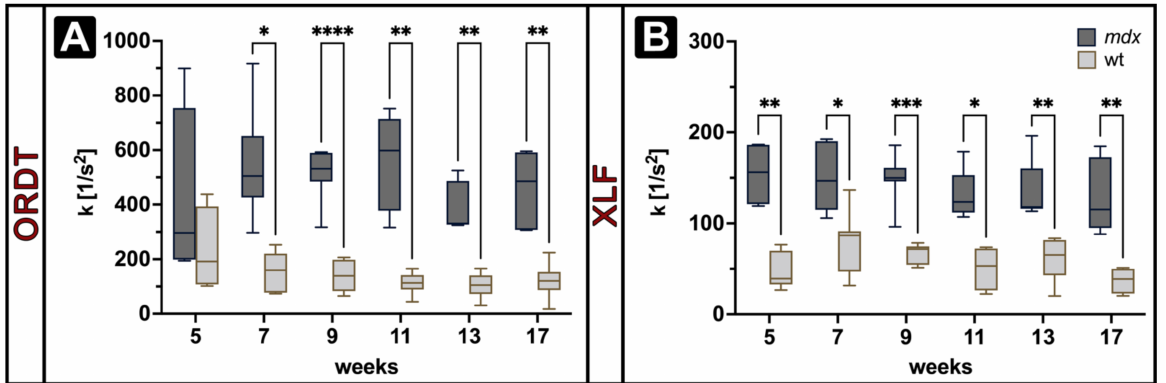
Figure 3. Expiration constant ( k ) derived from ORDT ( A ) and XLF ( B ) measurements in mdx and wt mice ( n = 5 at 5 weeks, n = 7 onwards) at 1400 ms breathing intervals. ORDT shows a significantly higher k in mdx group compared to wt at all observed time points except week 5. Similarly, XLF derived k is significantly higher in mdx group compared to wt at all observed time points. Both XLF and ORDT did not show a significant difference in k across weeks in each group. Box annotations rep- resent the median and 5–95% intervals. Statistical significance between groups on each measurement determined by Š í d á k’s multiple comparisons test * p < 0.05, ** p < 0.01, *** p < 0.001, **** p <